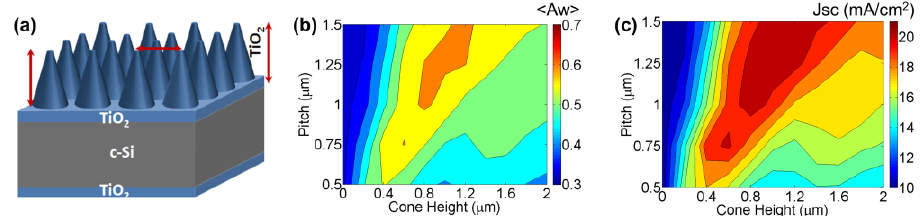
Figure 3. ( a ) Cell structure used for optimization of texture parameter using simulations. The structure consists of thin flat TiO 2 layers on the front and rear surfaces of flat silicon (1 µ m). The cones are only on the front surface without rear cones and Ag metal reflector; ( b ) Weighted absorption, < A w > and ( c ) Short-circuit current density, J SC , as a function of cone height for different pitch values. Figure shows optimum pitch >750 nm and cone height >500 nm with an increasing trend of tolerance of optimum cone height at larger pitch.